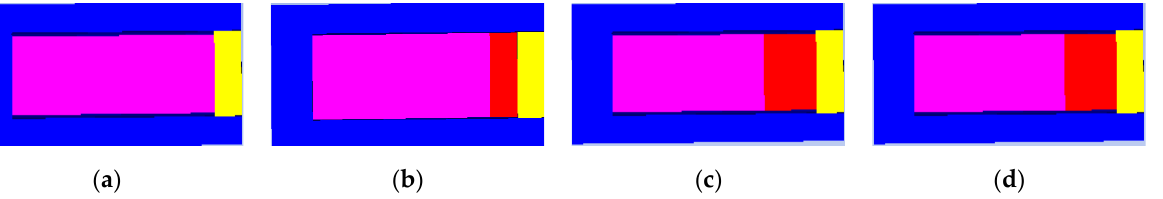
Figure 5. RMP model of impacting RHA steel target with different thicknesses: ( a ) 2 mm, ( b ) 8 mm, ( c ) 15 mm, and ( d ) 30 mm.